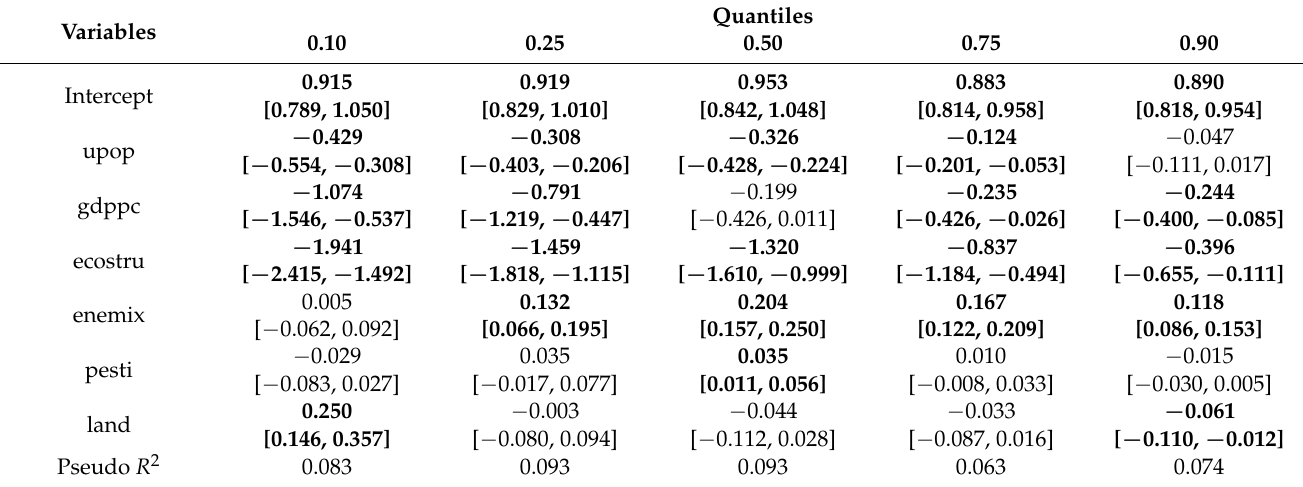
Table 6. Result of the Tobit quantile